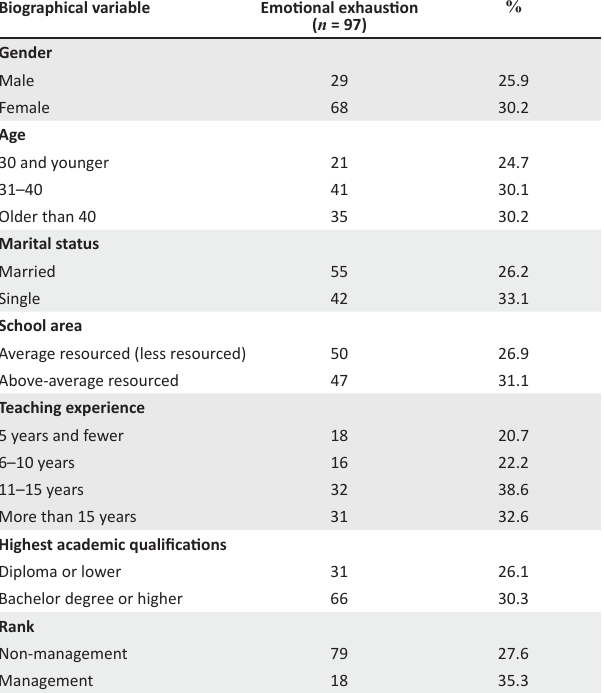
TABLE 5: Frequency distribution of teachers with high levels of emotional